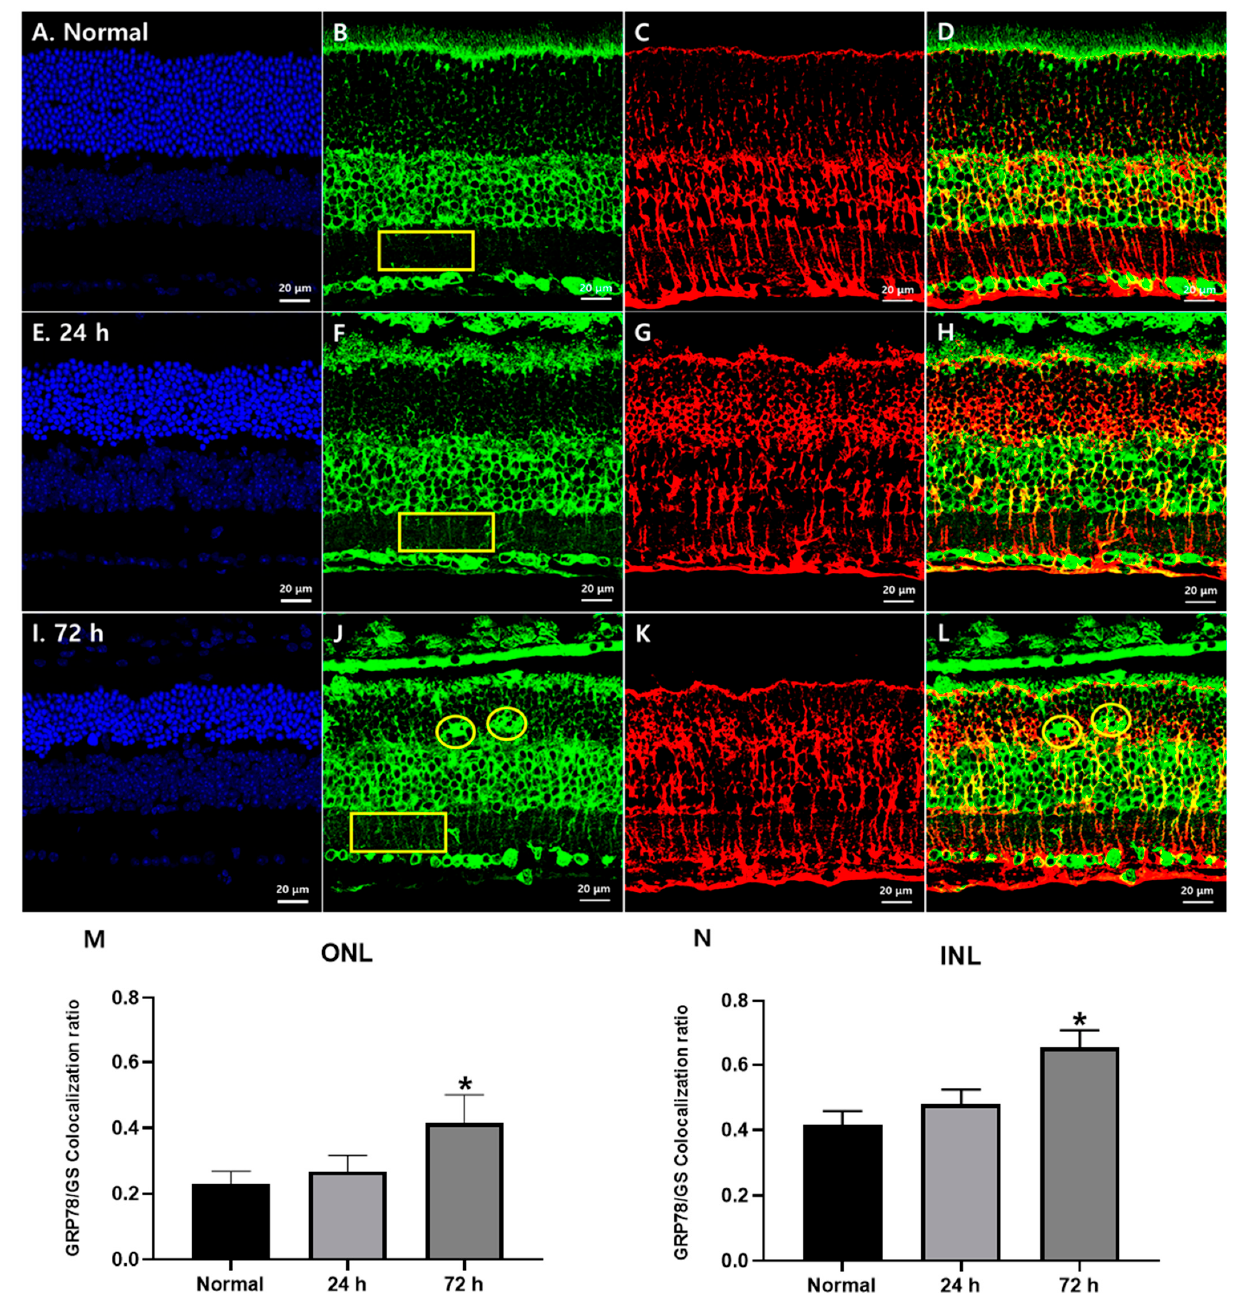
Figure 2. GRP78 expression in Müller glial cells in blue LED-induced RD retinas. ( A , E , I ) DAPI (blue) stained retina sections of the normal ( A ), 24 h ( E ) and 72 h ( I ) retinas after blue LED exposure. ONL thickness prominently decreased at 72 h. ( B , F , J ) GRP78 (green)-labeled sections of normal ( B ), 24 h ( F ) and 72 h ( J ) retinas after blue LED exposure. GRP78 was increased in the ONL and IPL in a time-dependent manner after LED exposure (yellow rectangles) and labeled in giant cells in the ONL (yellow circles). ( C , G , K ) GS (red)-labeled retina sections of the normal (C), 24 h (G) and 72 h (K) retinas after blue LED exposure. GS-labeled Müller cell processes enlarged and encircled photoreceptor cells in the ONL after injury. ( D , H , L ) Merged results of GRP78 and GS. GRP78 was increased in the Müller cell processes from IPL to ONL in a time-dependent manner while GRP78-labeled giant cells in the OPL showed no GS immunoreactivity (yellow circles). ( M – N ) Co-localization ratio of the GRP78/GS in the ONL (M) and IPL (N). In both the ONL and INL, the GRP78 co-localization ratio in GS-labeled Müller glial cells was significantly increased at 72 h after LED exposure ( n = 7, p < 0.05 (*), ANOVA).